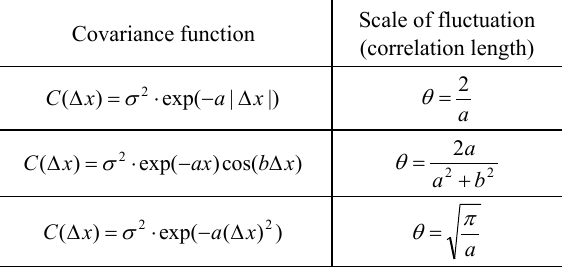
Table 1. Covariance functions and scales of fluctuation Covariance function